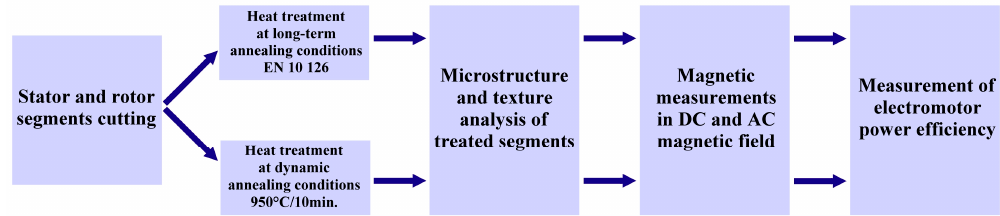
Figure 1. Scheme of experimental procedures which were used for investigated steel.